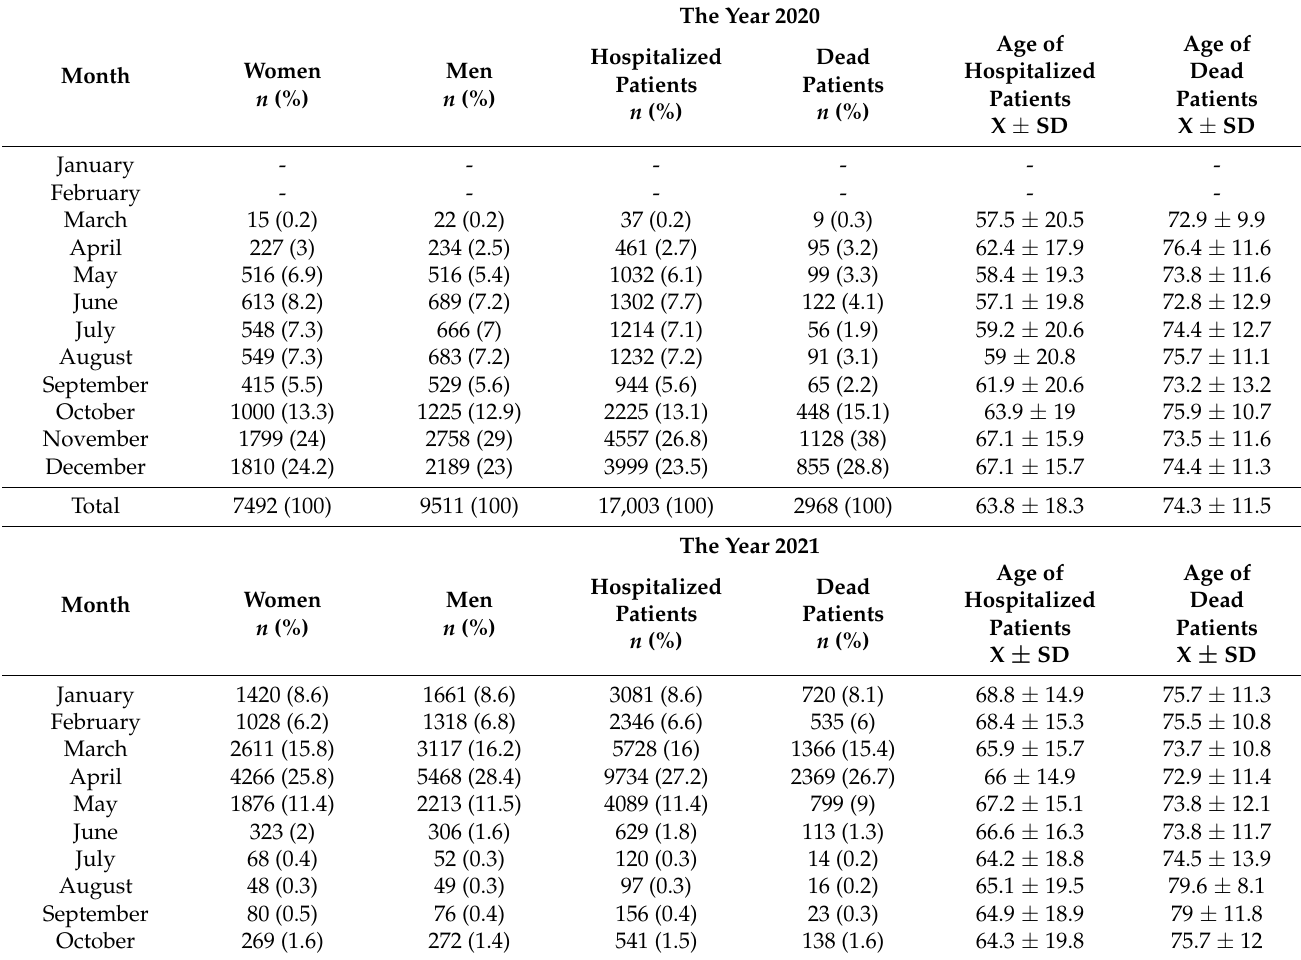
Table 1. Number and the average age of monthly hospitalized and dead COVID-19 patients in the Silesian voivodeship in the years 2020–2021 by the particular